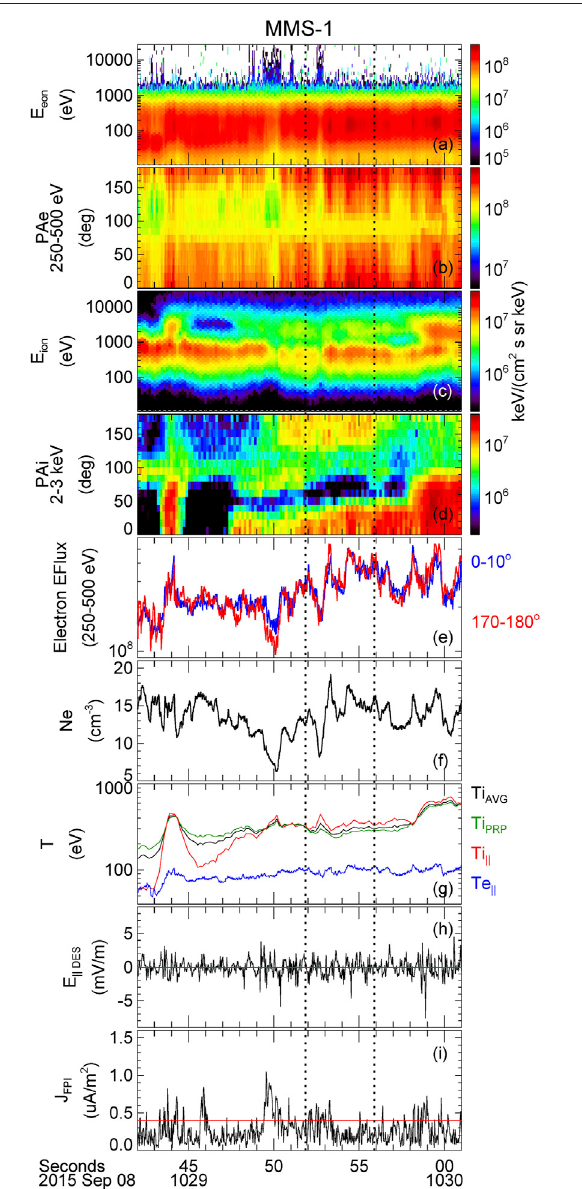
FIGURE8| MMS-1burstobservationsfrom1028:40UTto1028:56UT. Panels display (A) electron omni-directional energy-time spectrogram; (B) electron pitch-angle distribution in the 250 – 500 eV energy range; (C) ion omni-directional energy-time spectrogram; (D) ion pitch-angle distribution in the 2 – 3 keV energy range; (E) electron energy fl ux for 250 – 500 eV energy range parallel to the magnetic fi eld (0 – 10 o , blue) and anti- parallel to the magnetic fi eld (170 – 180 o , red); (F) electron plasma number density; (G) electron parallel temperature (Te || , blue), ion parallel temperature (Ti || , red), ion perpendicular temperature (Ti perp , green), and the ion average temperature Ti AVG (cid:1) (Ti || +2Ti perp )/3; (H) Parallel electric fi eld from the ADP instrument interpolated to the 30-ms DES instrument cadence; (I) magnitude of the current density GSM vector as measured by the FPI instruments. Vertical dotted lines mark the time period 1028:42.950 – 1028:43.849 UT associated with counter-streaming ions.